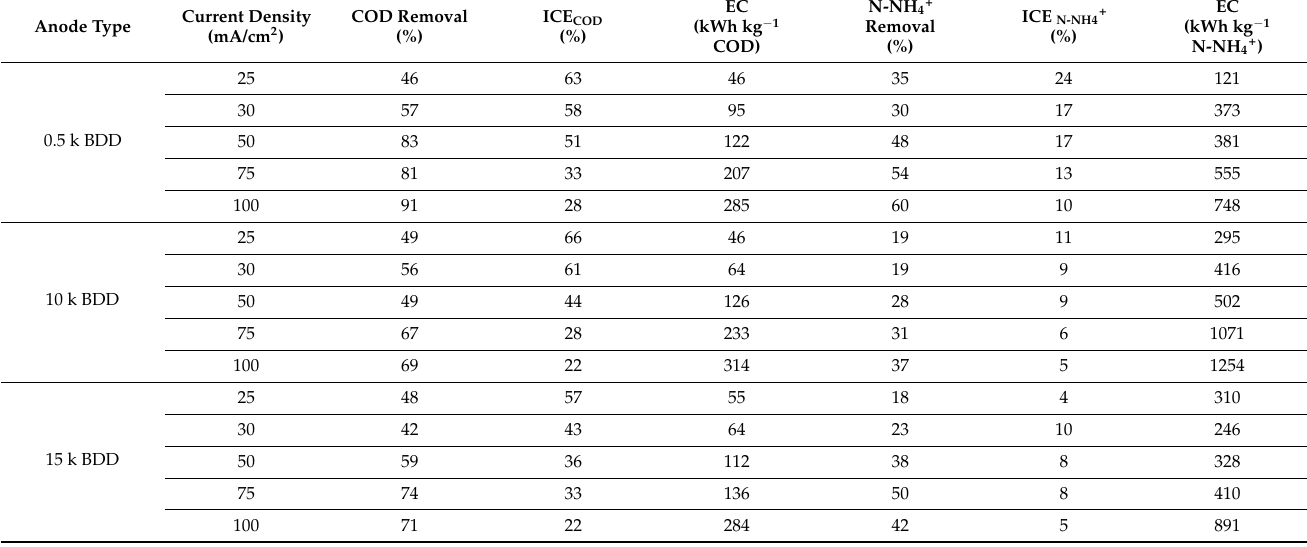
of EO of EO process.